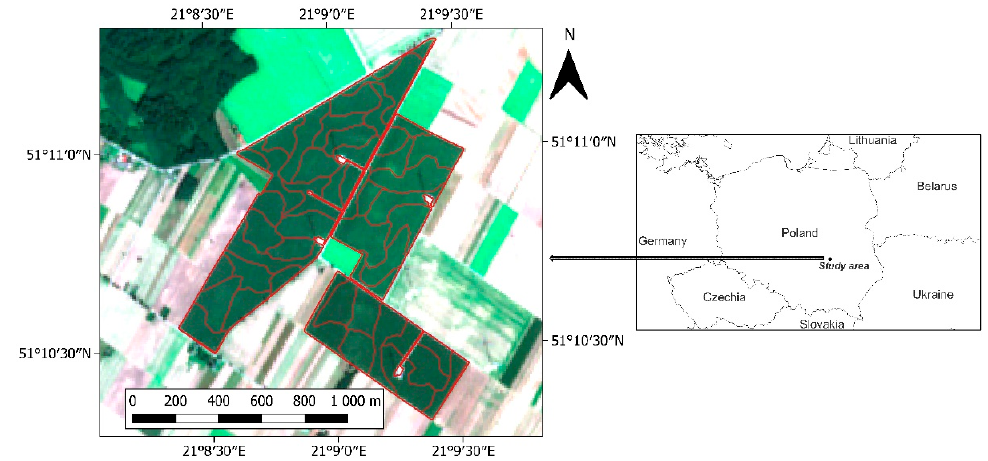
Figure 1. The studied fields with delineated management zones and their locations. Table 2. Correlation coefficients between nutrient content, pH and spectral indices, EC, and organic- matter content (significant correlations at 0.05 probability level are marked in